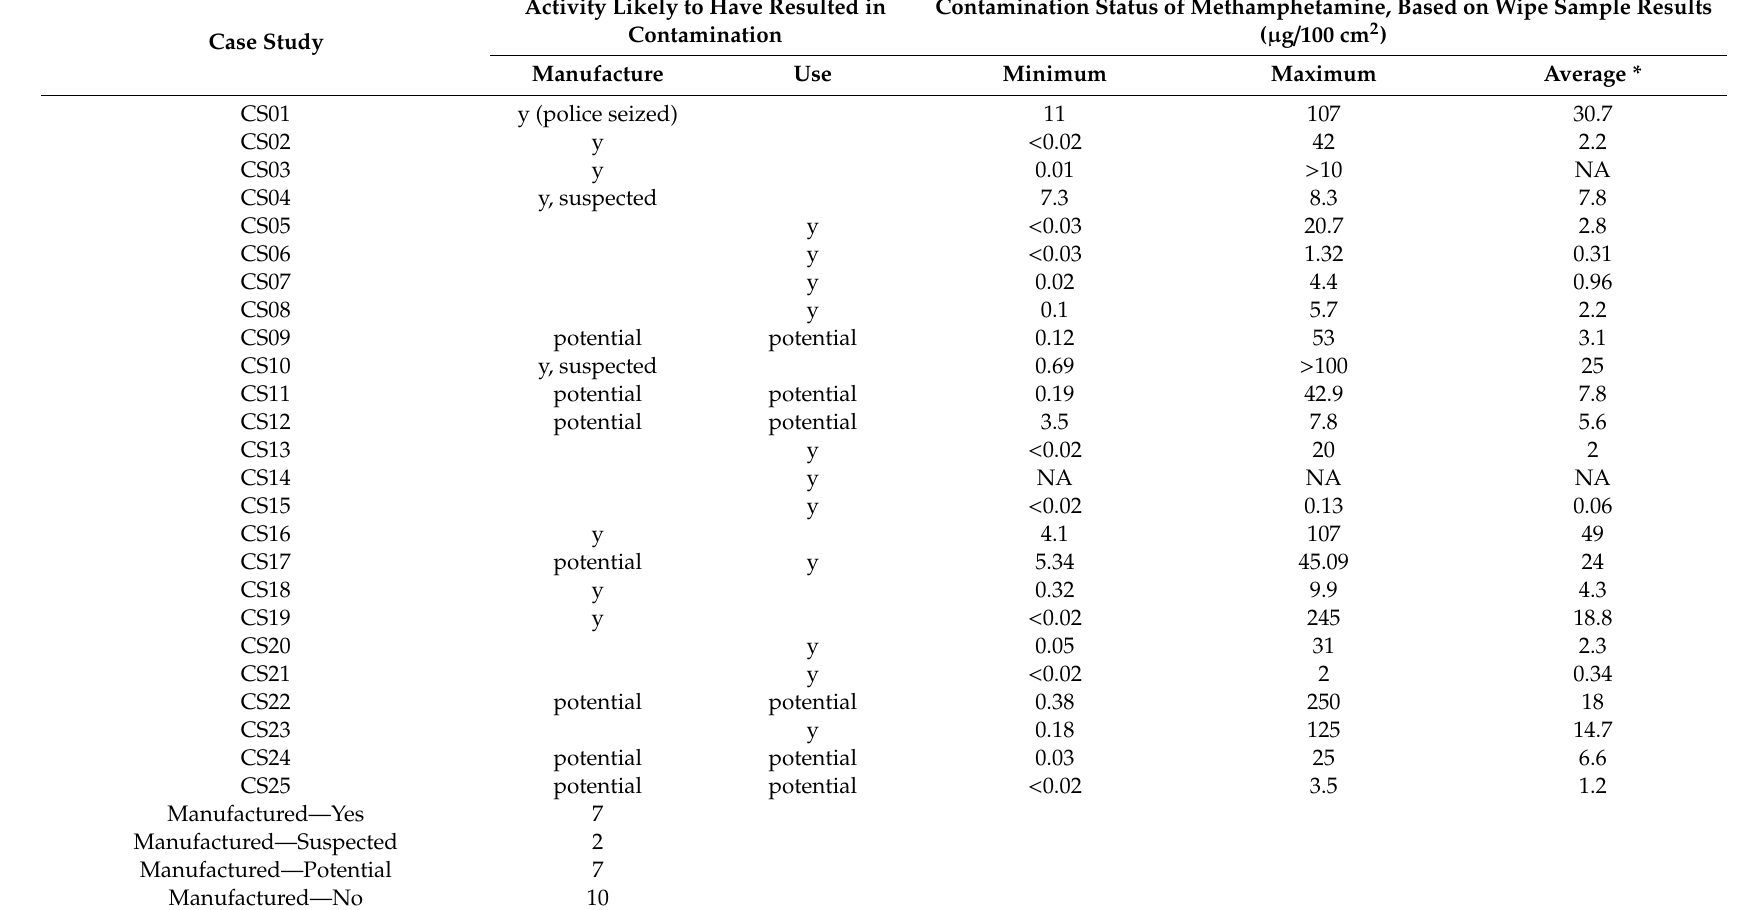
Table 2. Contamination status of properties included in case